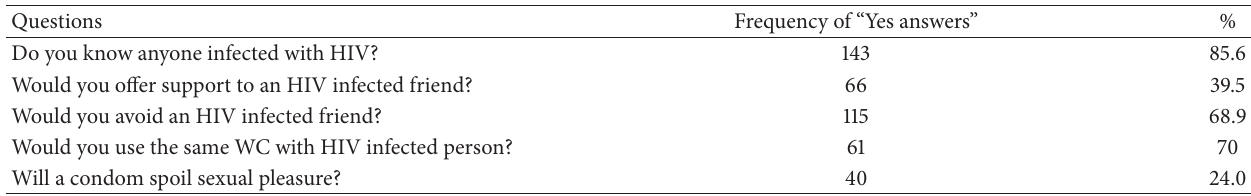
Table 3: Attitudes towards HIV prevention by respondents.